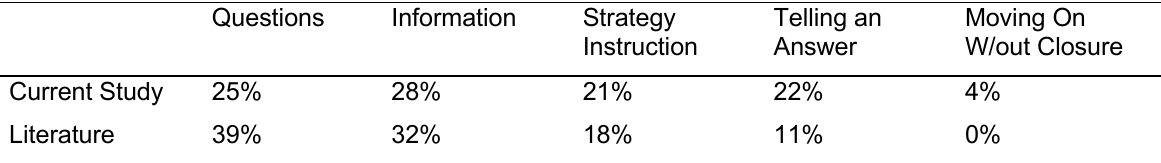
Table 6 Percentages of Third-Turn Moves in Current Study and Research